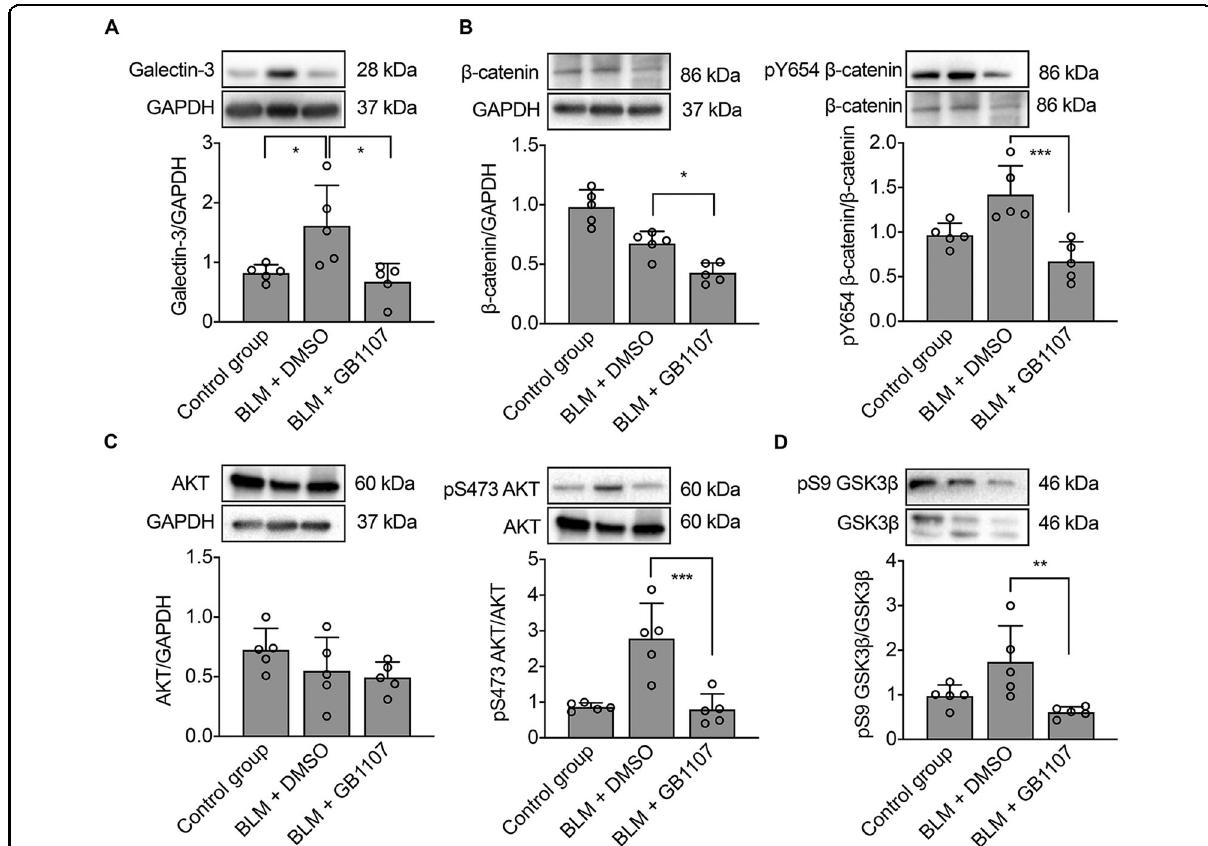
Fig. 6 Inhibition of galectin-3 downregulates the AKT/GSK3 β / β -catenin pathway in IPF mice. Western blot analysis of galectin-3 and AKT/ GSK3 β / β -catenin pathway proteins in lung tissue lysates. Control: saline for intratracheal injection. BLM + DMSO: positive control using BLM for pulmonary fi brosis model construction and intraperitoneal injection of vehicle (DMSO). BLM + GB1107: intraperitoneal injection of GB1107 to inhibit galectin-3 expression, n = 5 per group. Protein targets are A galectin-3; B β -catenin; pY654 β -catenin; C AKT, pS473 AKT; D pS9 GSK3 β ; * p < 0.05, ** p < 0.01, *** p <